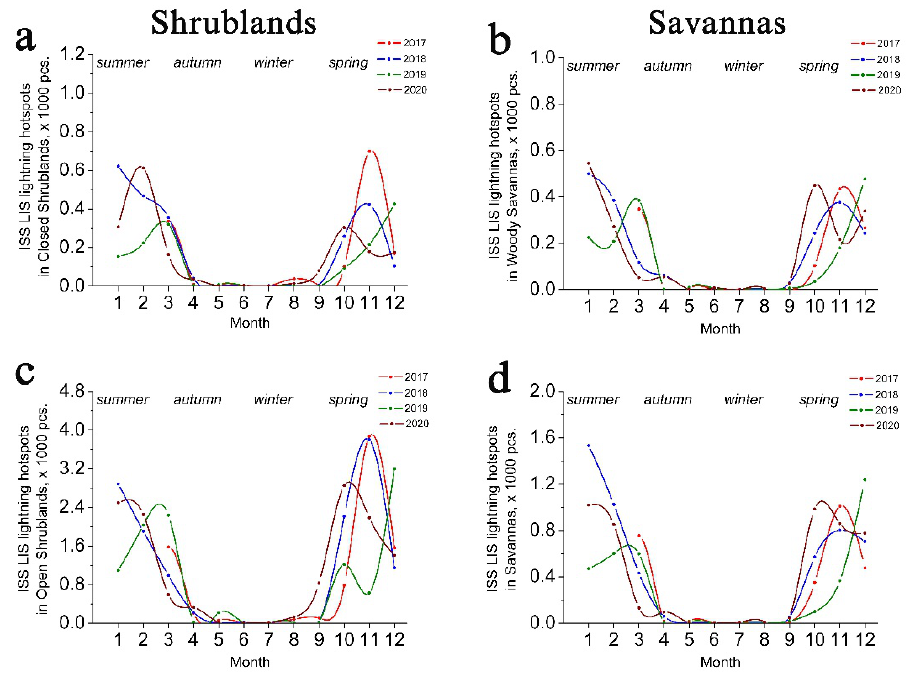
Figure 6. The monthly distributions of LISS ISS flashes, recorded in the open ( c ) and closed ( a ) shrublands, and in the woody ( d ) and grasslands savannas ( b ) in absolute values (pcs.) in the period 2017–2020. MODIS land cover (MCD12Q1) is used for estimations.